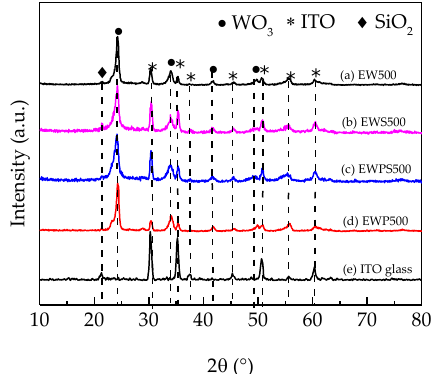
Figure 4. X-ray diffraction (XRD) patterns of different films: ( a ) EW500, ( b ) EWS500, ( c ) EWP500, ( d ) EWPS500, ( e ) indium tin oxide (ITO) glass. All of them were crystallized by annealing at 500 °C.